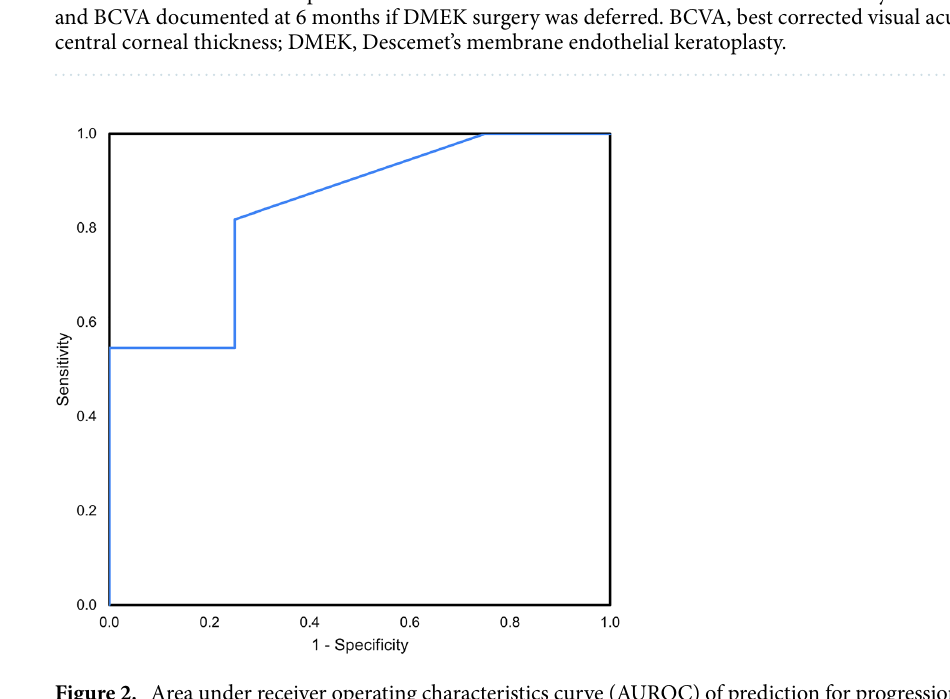
Figure 2. Area under receiver operating characteristics curve (AUROC) of prediction for progression to DMEK (AUROC =